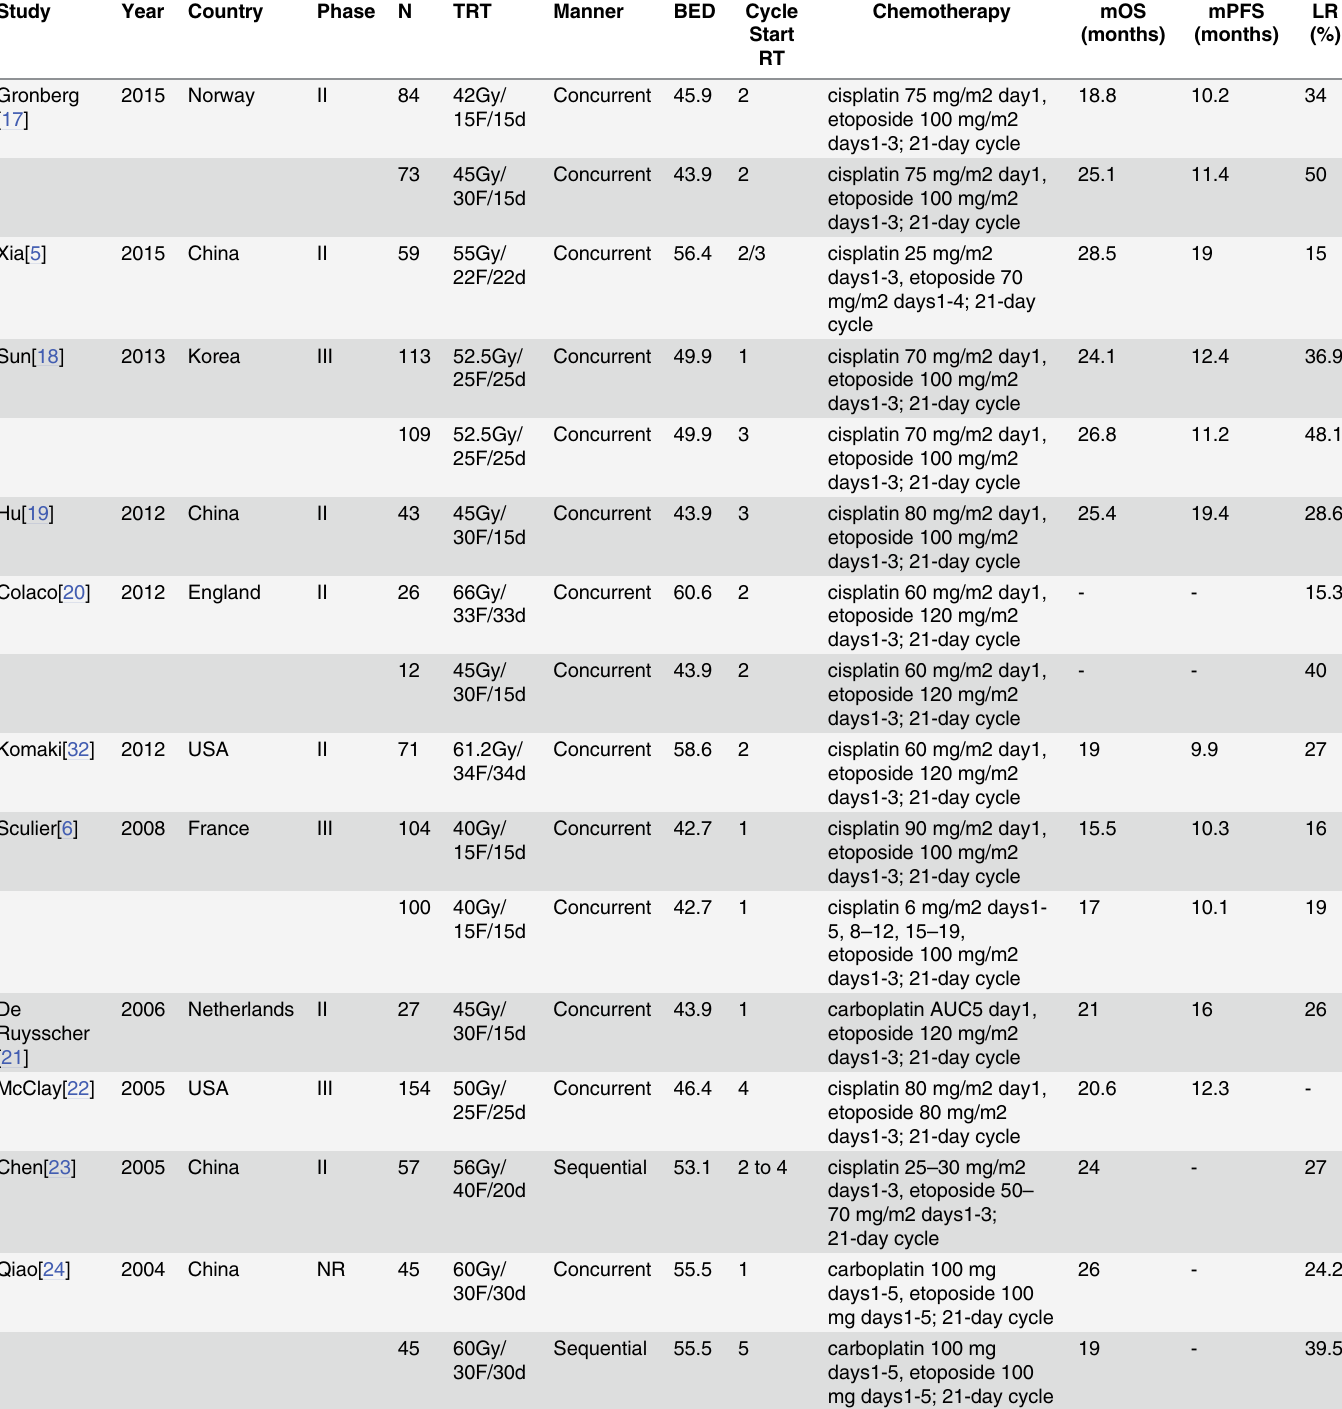
Table 1. Characteristics of 19 included